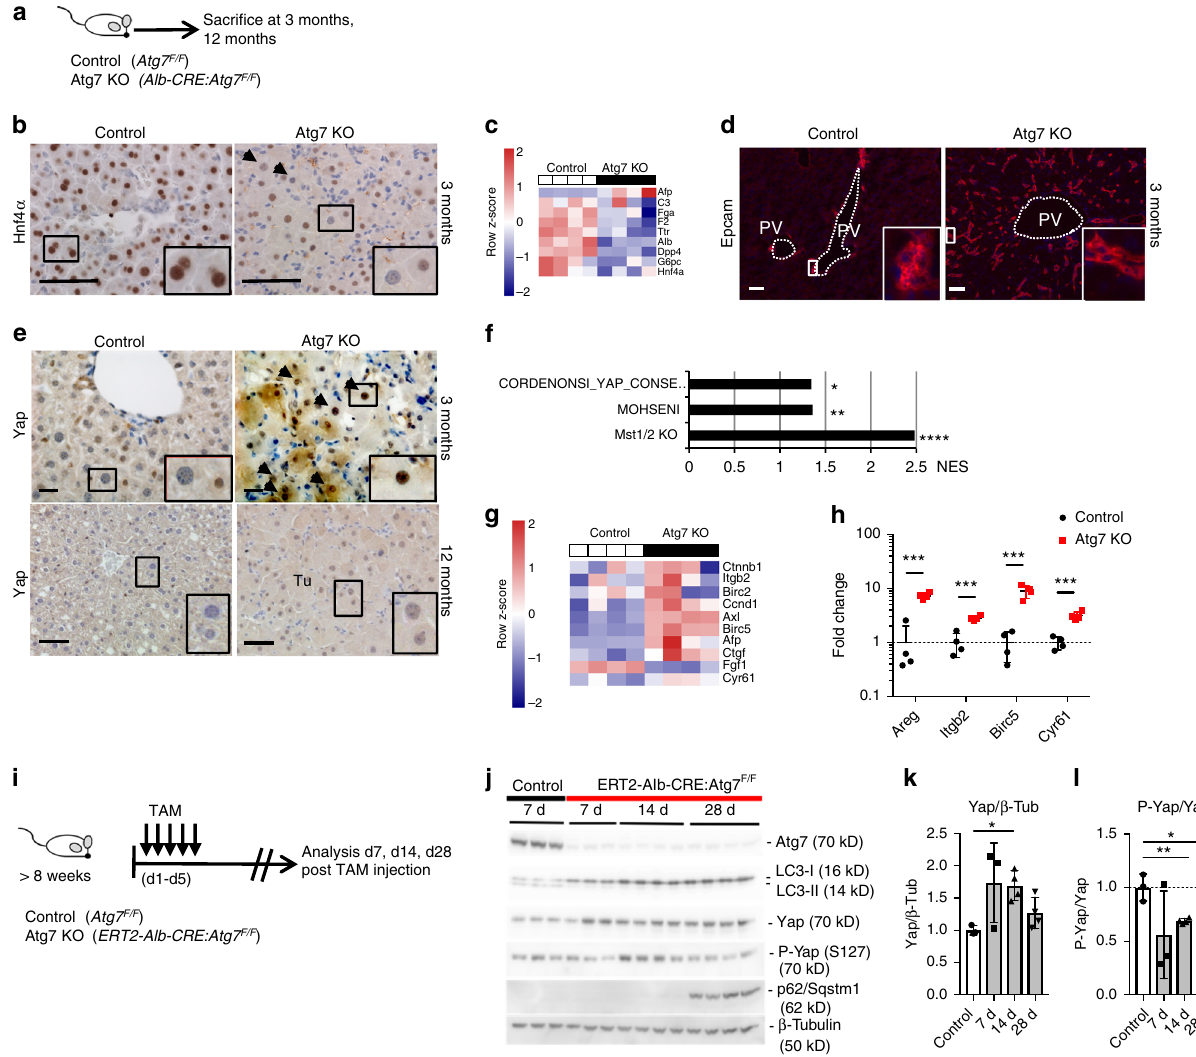
Fig. 1 Autophagy maintains Hippo/Yap pathway in liver. a Control ( Atg7 F/F ) and Atg7 KO mice ( Alb-CRE:Atg7 F/F ) were analyzed at 3 months ( n = 4) and 12 months of age ( n = 6 and 7 respectively). b Immunostaining for HNF4 α in control and Atg7 KO mice. c Gene expression array analysis of whole liver RNA from controls and Atg7 KO animals. Data indicate row z -scores. d Immunostaining for Epcam in control and Atg7 KO mice. e Immunostaining for Yap in control and Atg7 KO liver sections at 3 months and 12 months. Tu, tumor. f Gene set enrichment analysis for enrichment of Hippo/Yap gene signatures and plotting of NES scores. NOM P -value * P < 0.05, ** P = 0.001, **** P < 0.0001. NES, normalized enrichment score. g Gene expression array analysis of whole liver RNA from controls and Atg7 KO for Yap downstream targets. Data indicate row- z scores. h qRT-PCR analysis of whole liver RNA from control and Atg7 KO mice at 3 months for Yap downstream targets. Data normalized to Gapdh mRNA expression and expression in control mice. Data represent two independent experiments. Mean ± SD. ** P < 0.01, *** P < 0.001 by two tailed t -test. i Tamoxifen (TAM)-inducible, hepatocyte-speci fi c Atg7 KO ( ERT2- Alb-CRE:Atg7 F/F ) and respective controls were analyzed 7, 14, and 28 days after TAM injection. j Immunoblotting of whole liver lysates from control and Atg7 KO mice, 7, 14, and 28 days after tamoxifen injection. k Quantitative band densitometry of Yap and β -tubulin immunoblots normalized to Yap/ β - tubulin ratios in control mice. ** P < 0.005 by two tailed t -test compared to controls. l Band densitometry of P-Yap and Yap immunoblots normalized to P- Yap/Yap ratios in control mice. ** P < 0.005 and * P < 0.05 by two tailed t -test compared to controls. Scale bar 100 µ m. Insets in b , d , e in the lower right corners correspond to small boxes within the associated lower magni fi cation